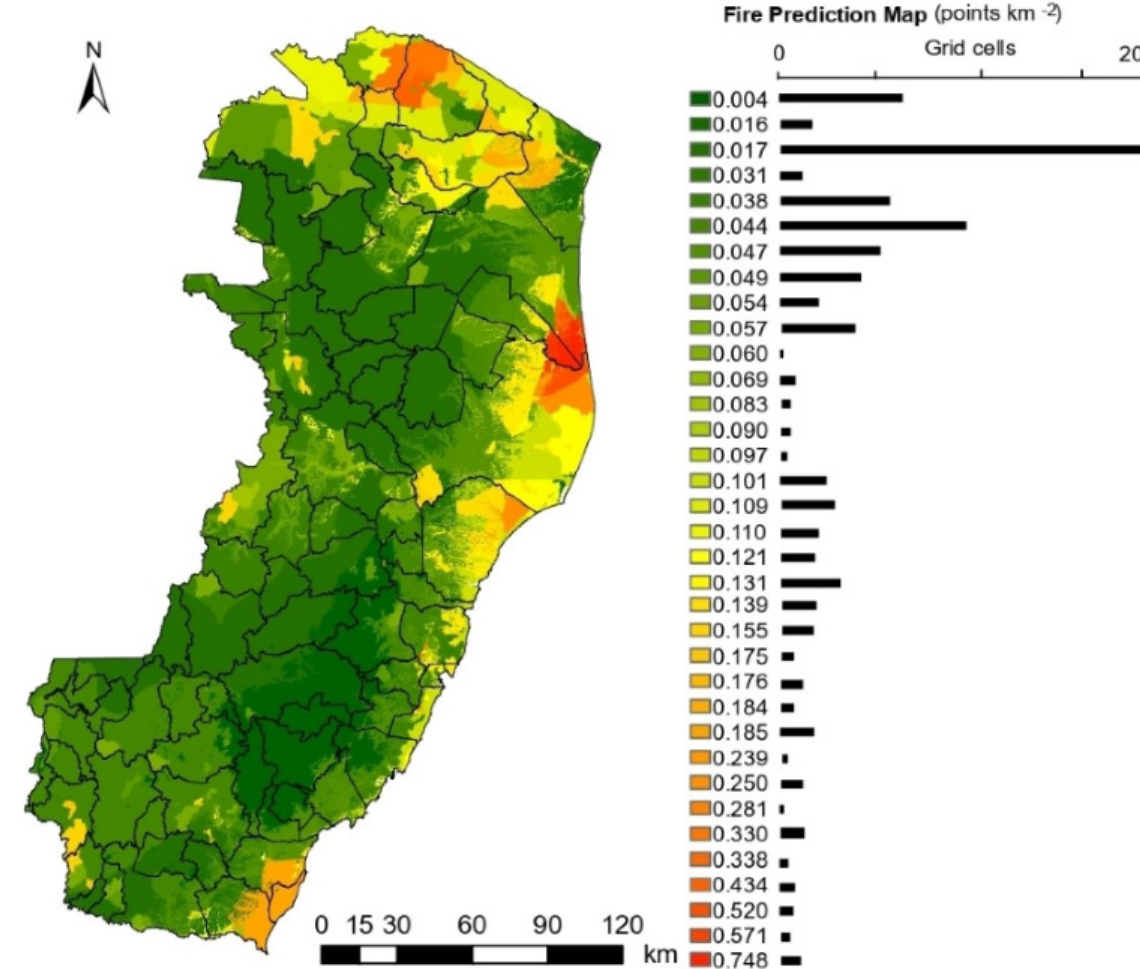
Figure 5. Fire prediction map obtained by application of decision